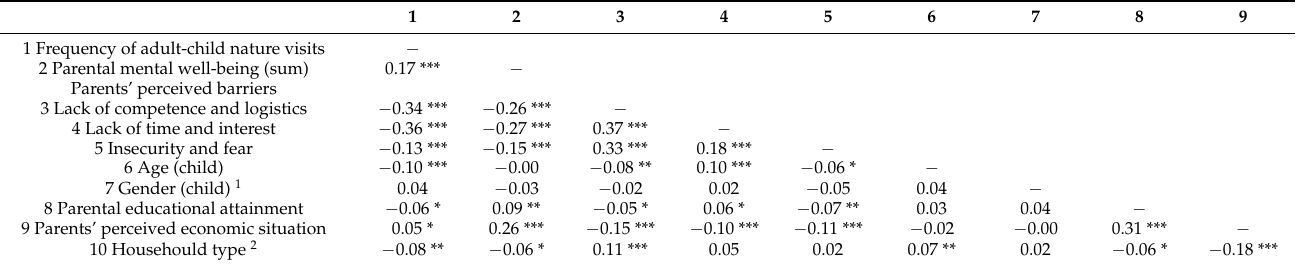
Table 3. Bivariate correlations among study